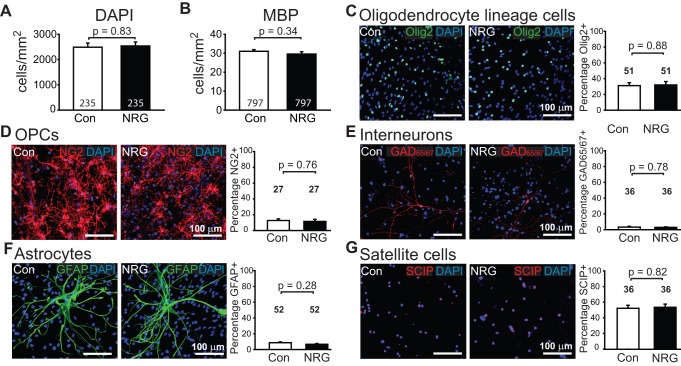
NRG has no effect on cell density.(A, B) Total number of DAPI-labelled cells (A) and number of MBP-expressing oligodendrocytes (B) in control and NRG-treated cultures. (C–G) Images of labelled cells in control and NRG, and bar chart showing the percentages of cells, which were (C) Olig2-expressing oligodendrocyte lineage cells, (D) NG2-expressing OPCs, (E) GAD-expressing interneurons, (F) GFAP-expressing astrocytes, and (G) SCIP-expressing satellite cells. Number of fields of view counted per condition are shown on bars; 10 fields were imaged per coverslip.